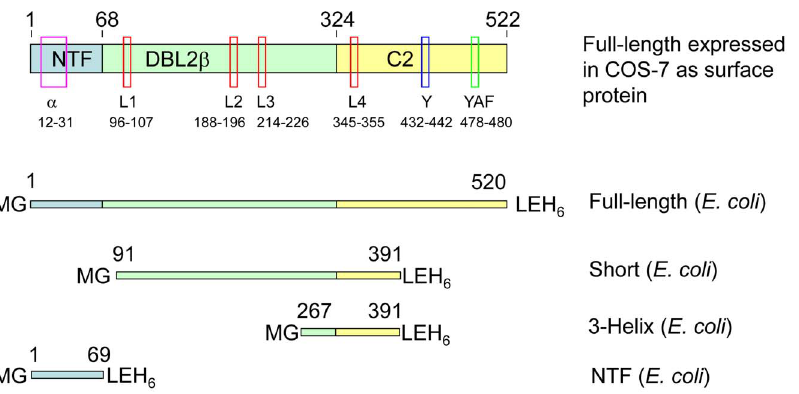
Figure 1. Schematic representation of several DBL2 b domain structural features and constructs expressed in E.coli . For relevance to older works, domain is shown as a combination of NTF, DBL b and C2 parts according to previous nomenclature. NTF, N-terminal fragment. Semi- conserved and conserved features [20,21,24] are indicated by black boxes: a , first alpha helix; L1 through L4, Loops 1 through 4; Y, Y – motif; YAF, Tyr- Ala-Phe. Numbers above proteins and under structural features indicate position of amino acid (AA) residues. Additional AA residues at the protein ends, which appear as a result of cloning, are indicated for each E. coli expressed fragment using single letter code.